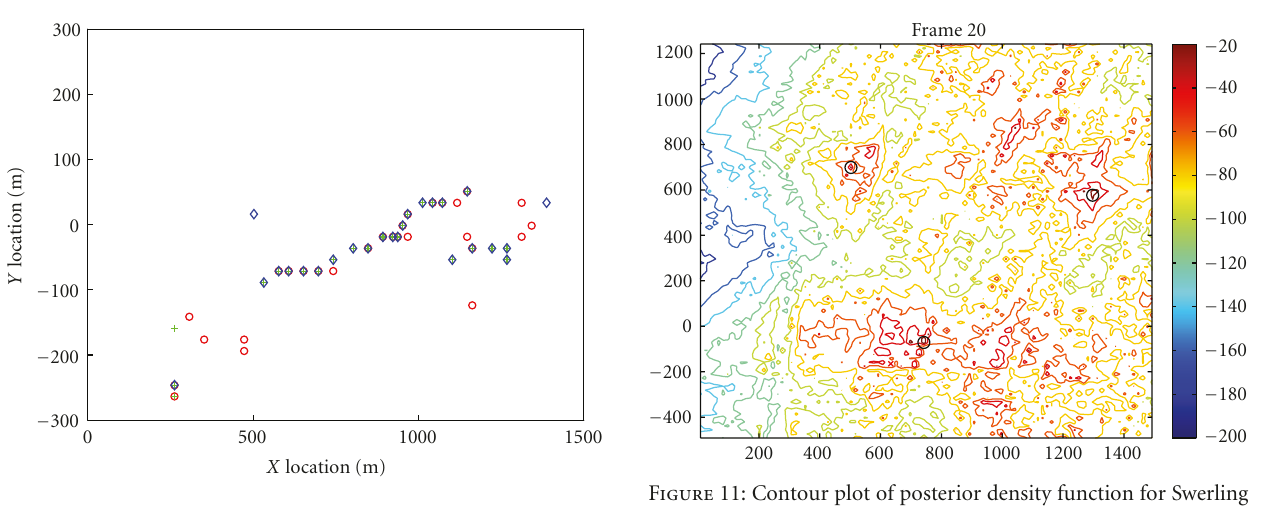
Figure 11: Contour plot of posterior density function for Swerling 0 model on selected scan.